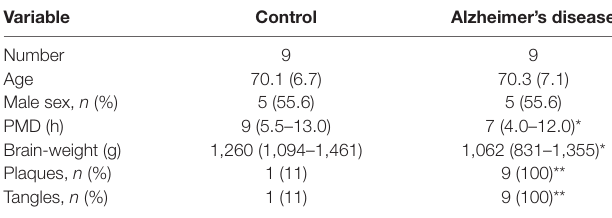
TABLE 2 | Case-control study of post-mortem human brain in Alzheimer’s disease: group